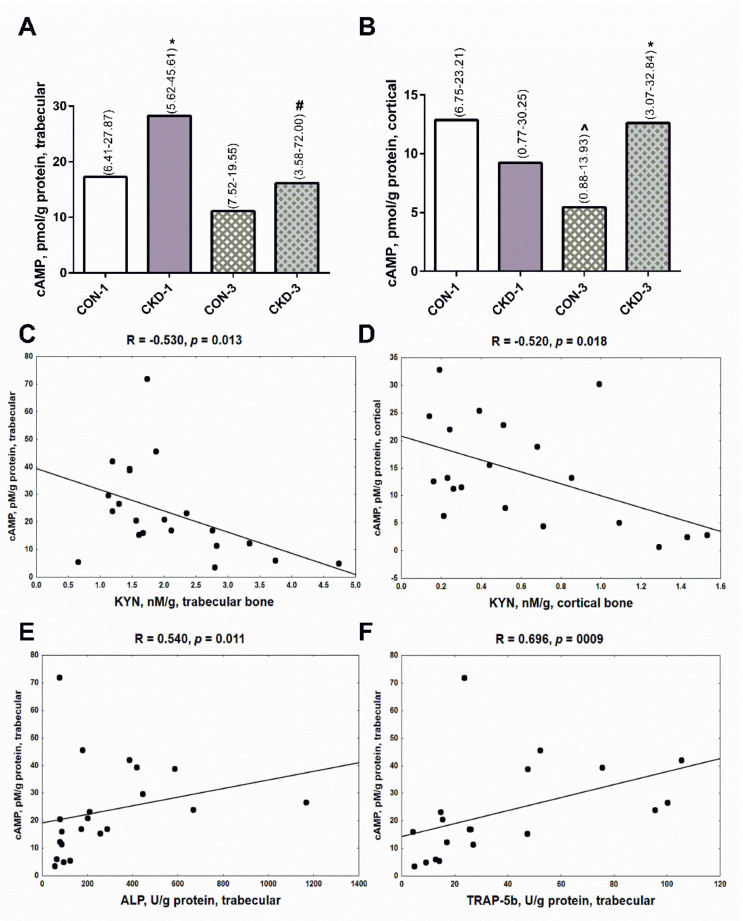
Figure 4. The concentrations of cAMP in bone of young rats with chronic kidney disease (CKD) ( A , B ), and its association with bone kynurenine ( C , D ) and bone turnover markers ( E , F ). Data are median (full range). * p < 0.05 controls versus appropriate CKD group; ˆ p < 0.05 CON-1 versus CON-3; # p < 0.05 CKD-1 versus CKD-3; Abbreviations: cAMP = cyclic adenosine monophosphate; CON-1 = sham operated rats, 1 month after surgical intervention; CON-3 = sham operated rats, 3 month after surgical intervention; CKD-1 = subtotal nephrectomized rats, 1 month after surgical intervention; CKD-3 = subtotal nephrec- tomized rats, 3 month after surgical intervention; CKD = chronic kidney disease; KYN = kynurenine; ALP = alkaline phosphatase; TRAP-5b = tartrate-resistant acid phosphatase